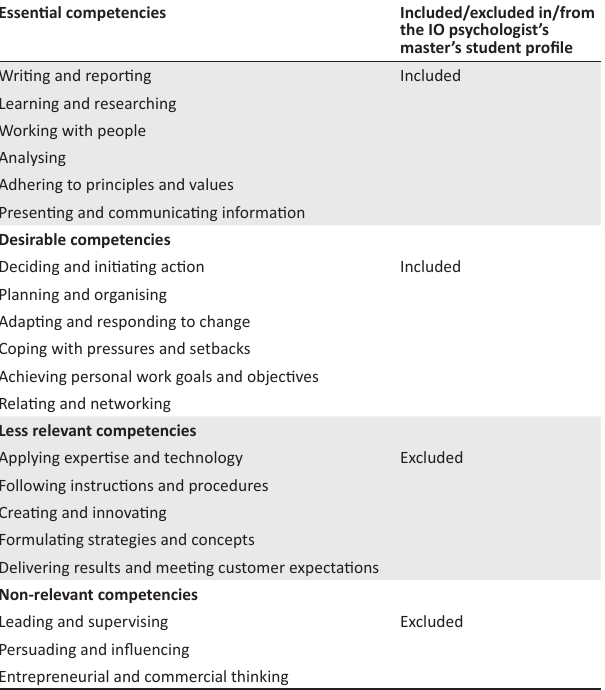
the IO psychologist’s master’s student profile